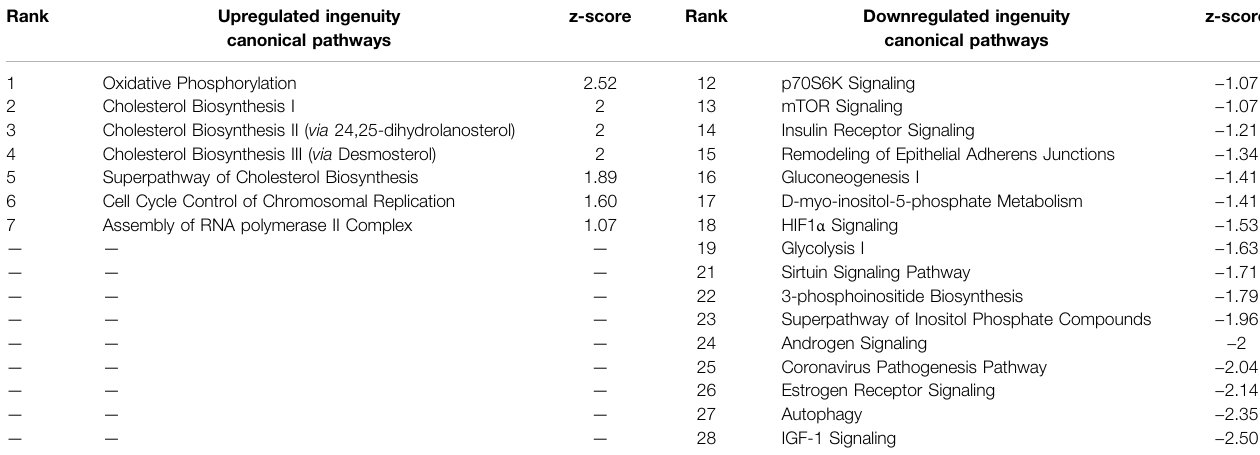
TABLE6| IngenuityPathwayAnalysistableofCanonicalPathwaysfromTPxTBDEGs( p < 0.01,logfoldchange > 1/ < -1).Redundantpathways,pathwayswithnoz-scoreor z-score between -1 and one removed. Mapped IDs: 3550; unmapped IDs: 838.184 analysis-ready molecules: 103 upregulated and 81 downregulated. Ranked by z-score. Left: upregulated pathways. Right: Downregulated pathways.